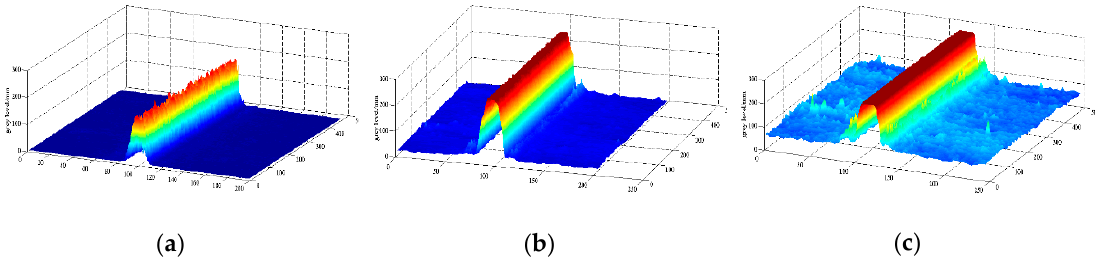
Figure 4. Laser stripe imaging features at di ff erent CCD imaging states. ( a ) Short CCD integral time; ( b ) Optimal laser imaging; ( c ) Long CCD integral time.